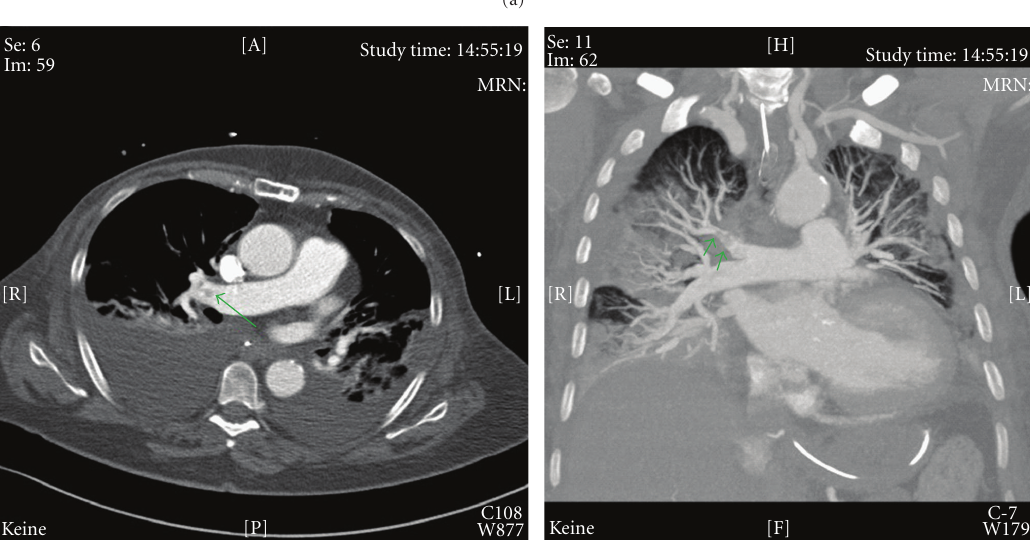
Figure 3: Coronary and axial cuts of the computed tomography of the chest at day 3 after onset of ARDS. d: day; ARDS: acute respiratory distress